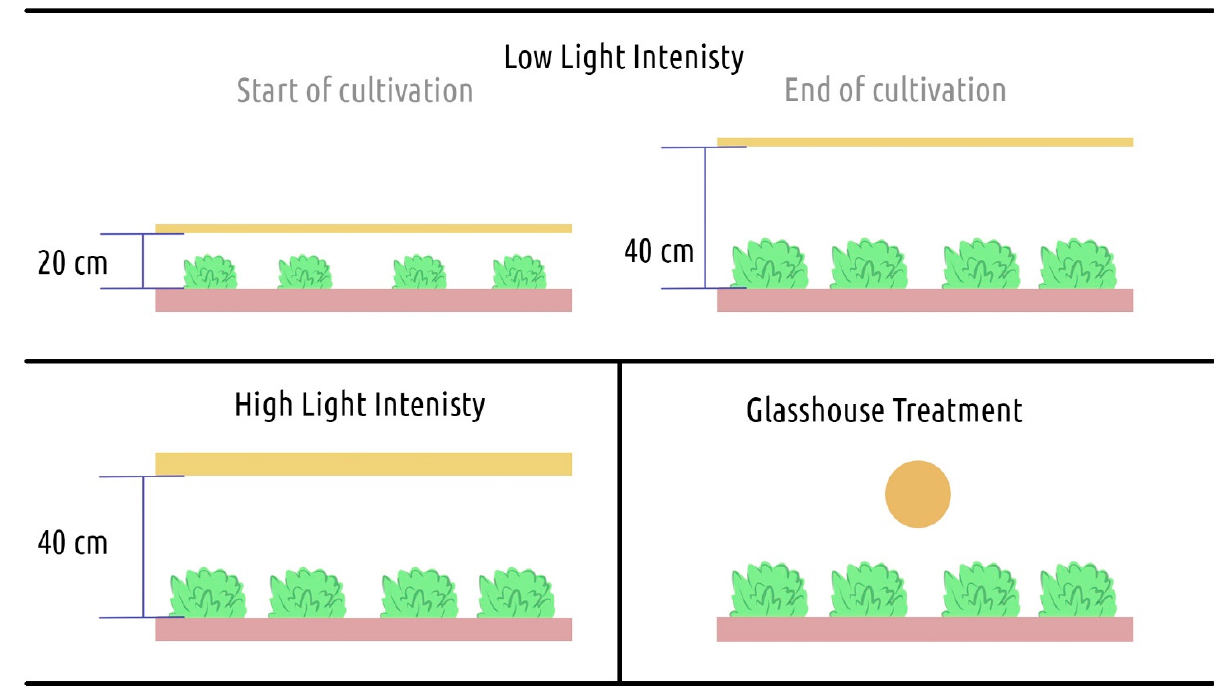
Figure 1. Schematic representation of the treatments. Low Light Intensity (LLI), High Light Intensity (HLI), Glasshouse Treatment (GT).